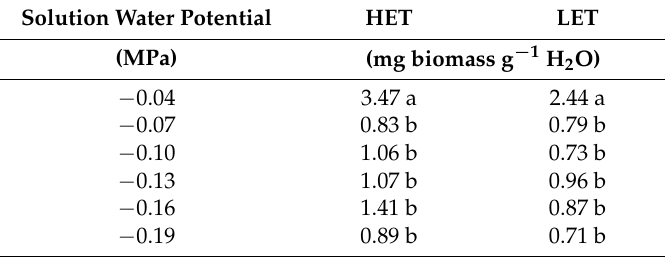
Table 2. Water use efficiency (WUE) in rice plants grown at different solution water potentials and at HET and